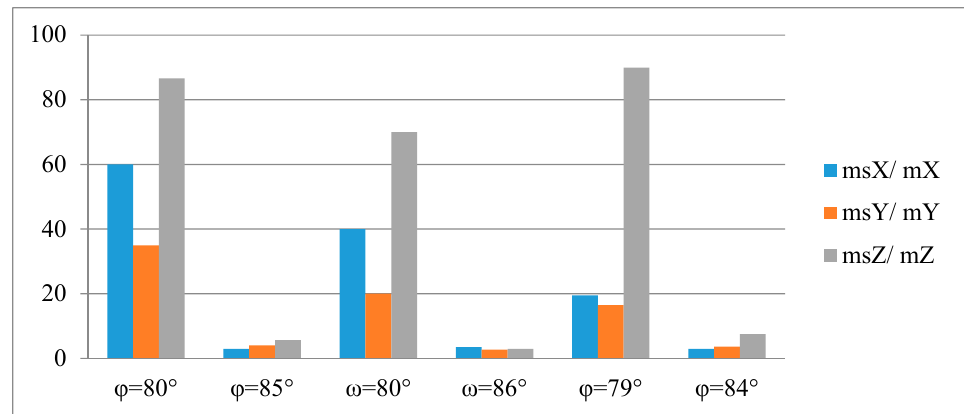
Figure 10. Ratios of the RMSE of the point coordinates calculated using simplified set of collinearity equations to the RMSE of the point coordinates calculated using classic collinearity equations for configuration I.